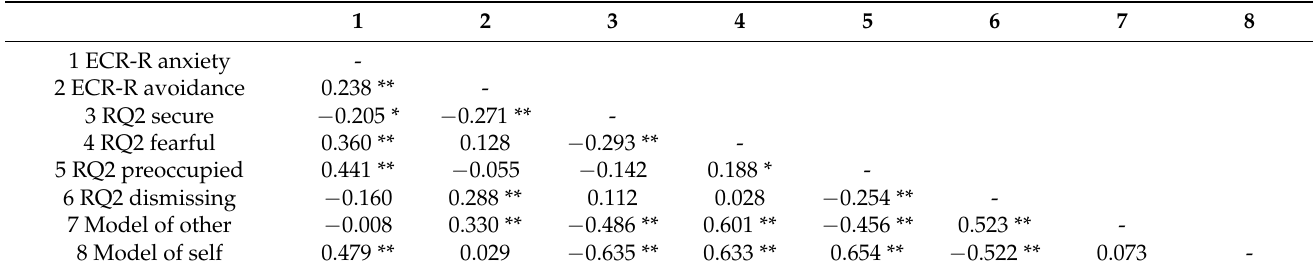
Table 3. Comparison of RQ with the ECR-R scales.